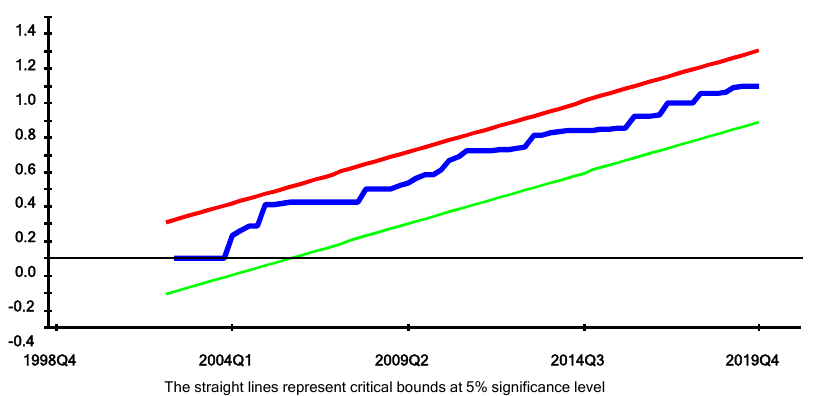
Figure 3. Plot of Cumulative Sum of Squares Recursive residuals. Source: Author’s Calculation.